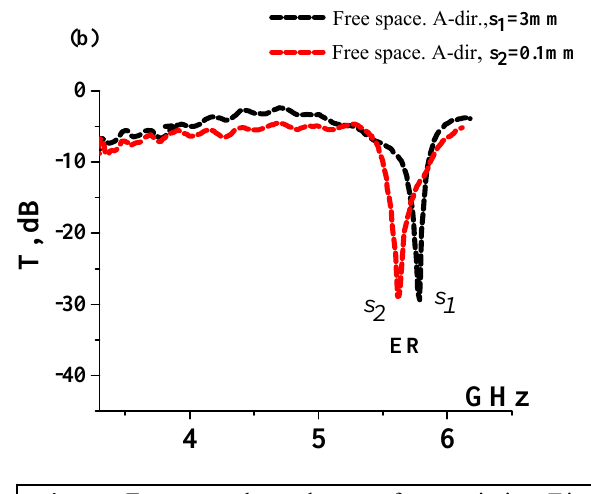
Fig. 11. Frequency dependences of transmission T in the prese nce of “ s 2 =0.1mm in ( a) the WG and cutoff WG and (b) free